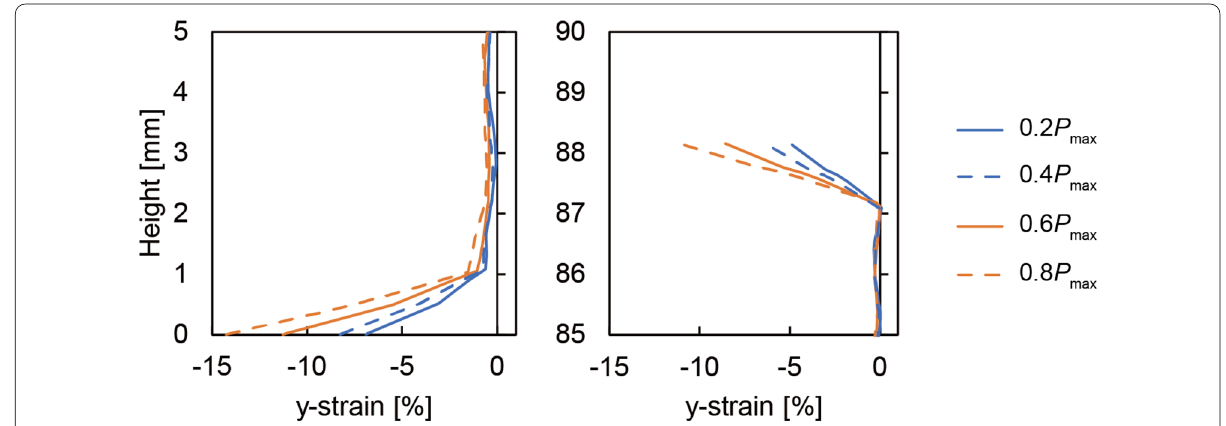
Fig. 7 Strain distribution of specimen no. 3-9 in damage zone at each load